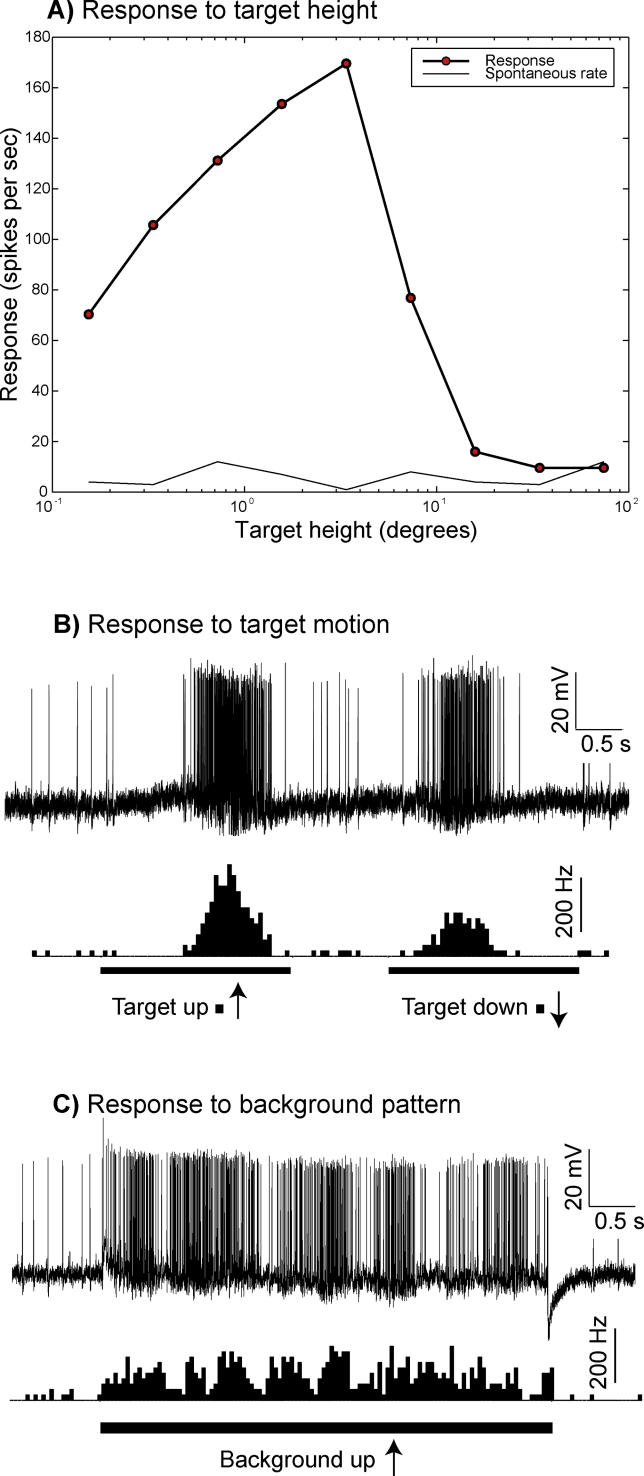
Responses of a Weakly Direction-Selective STMD Neuron That Responds to the Visual Clutter Stimulus(A) Length tuning to discrete bar stimuli (seeFigure 2) is typical of STMD neurons, with clear tuning to small features.(B) Raw responses to a target drifted in alternating directions show a vigorous, sustained response as the target crosses the receptive field.(C) The clutter stimulus (Figure 3A) produces an erratic and weaker response.